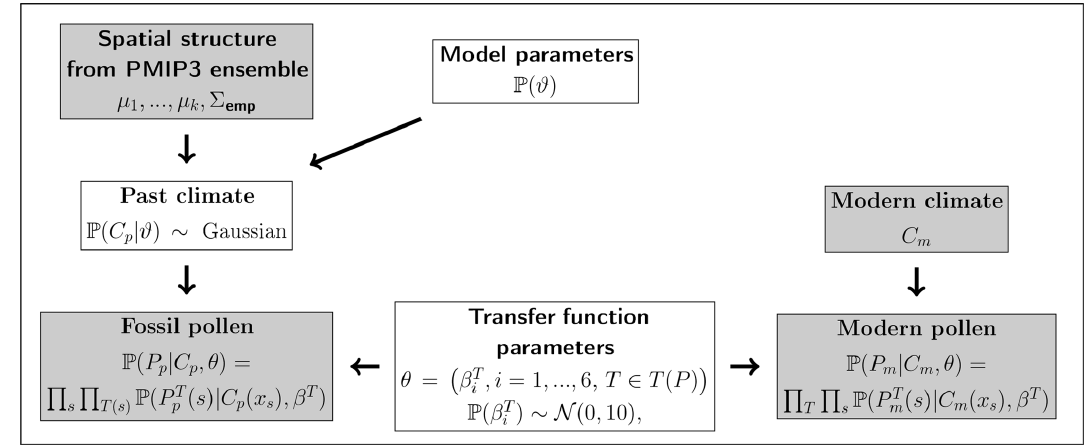
Figure 2. Directed acyclic graph corresponding to the Bayesian framework in Eq. (2). Involved quantities are given by nodes, and arrows indicate the dependencies of variables. White: inferred quantities; gray: input data.